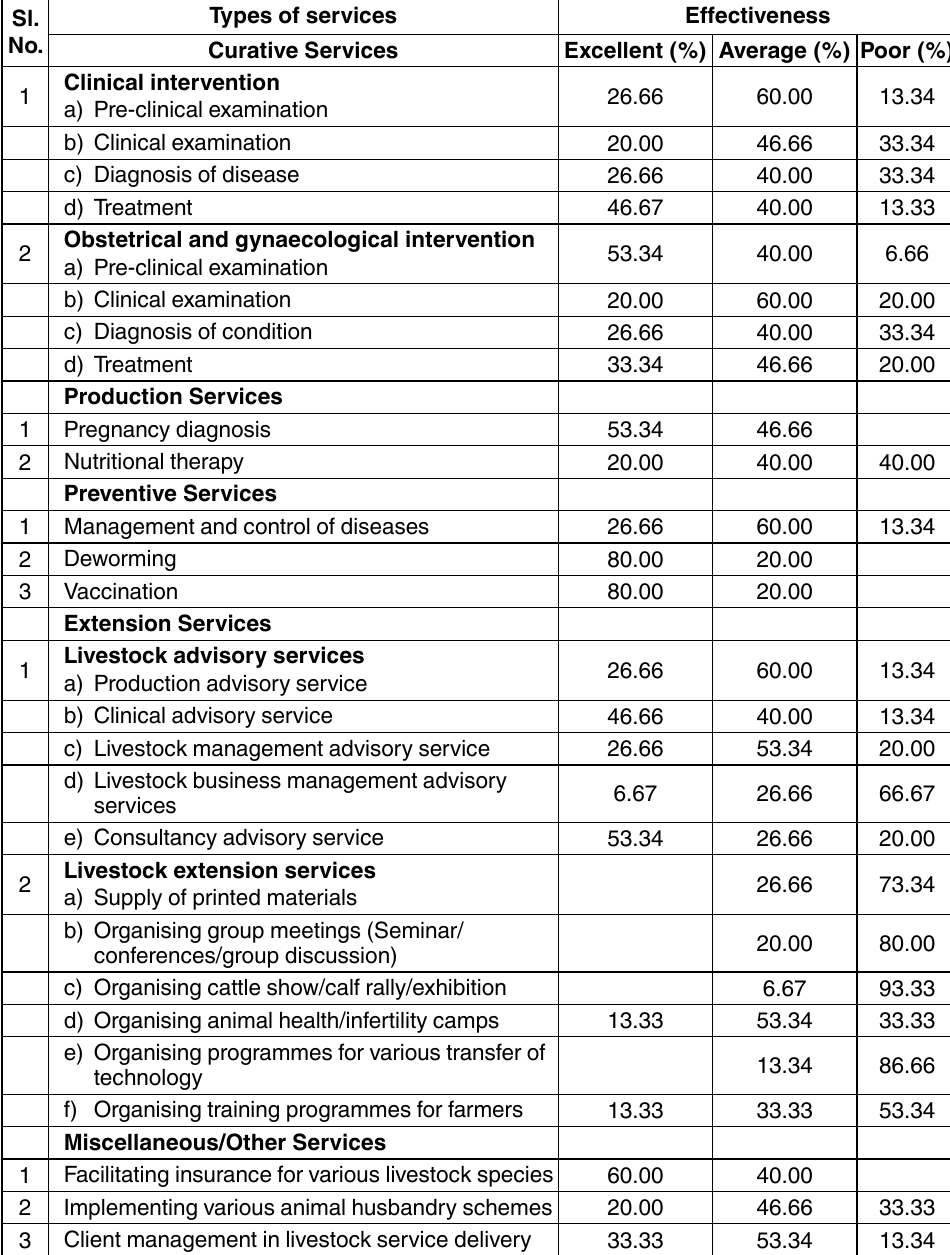
Table 1. Effectiveness of livestock delivery services as perceived by the veterinarians working under dairy cooperatives of Kerala